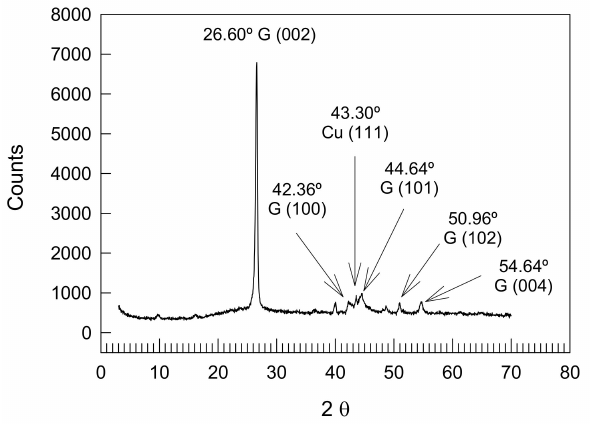
Figure 6. XRD pattern of AEG-LDG.